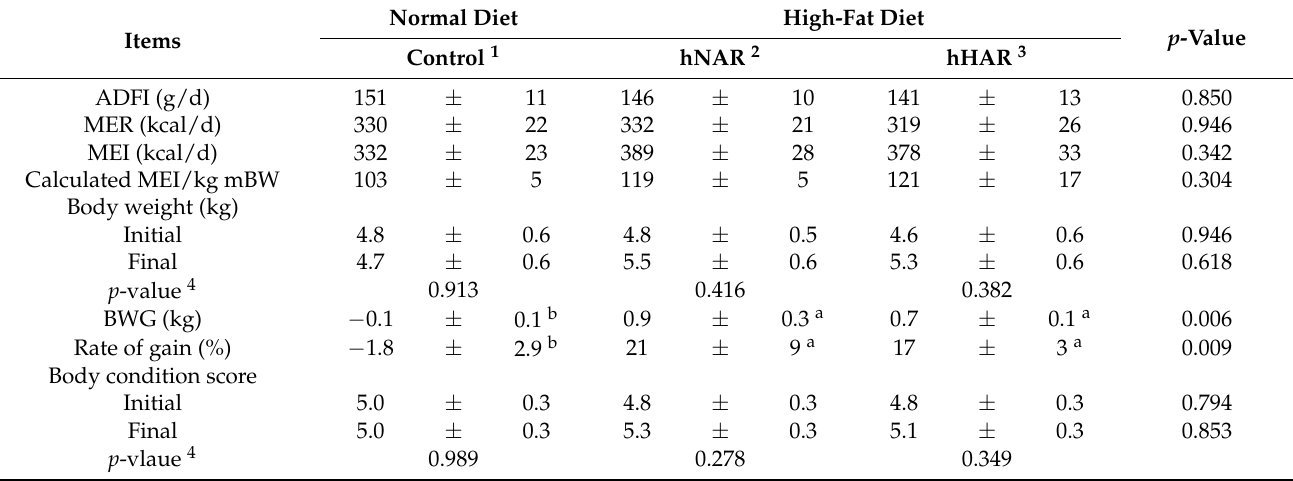
Table 3. Effects of high-fat diets with high amylose type rice on feed intake and body parameters in dogs (Exp.